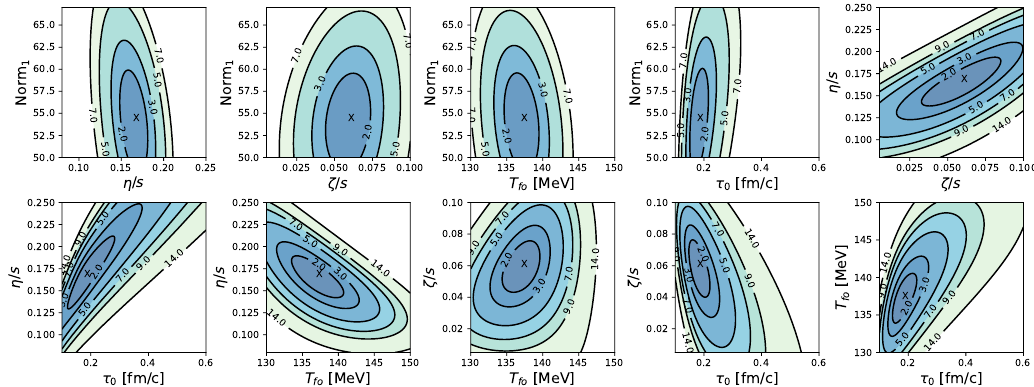
Figure 1 . Contour plots of (cid:31) 2 =N dof as a function of pairs of model parameters with all other parameters kept at the global minimum. The cross denotes the position of the